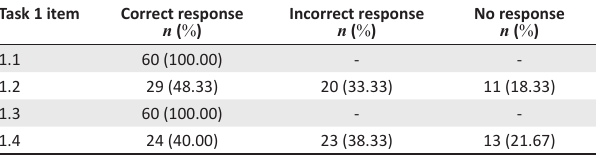
TABLE 1: Total number of participants’ responses to Task